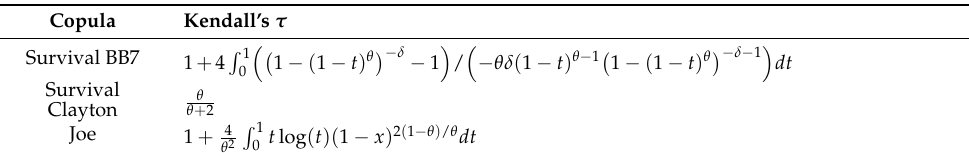
Table 5. The theoretical value of Kendall’s τ corresponding to the bivariate copula for given parameter values θ or ( θ , δ )